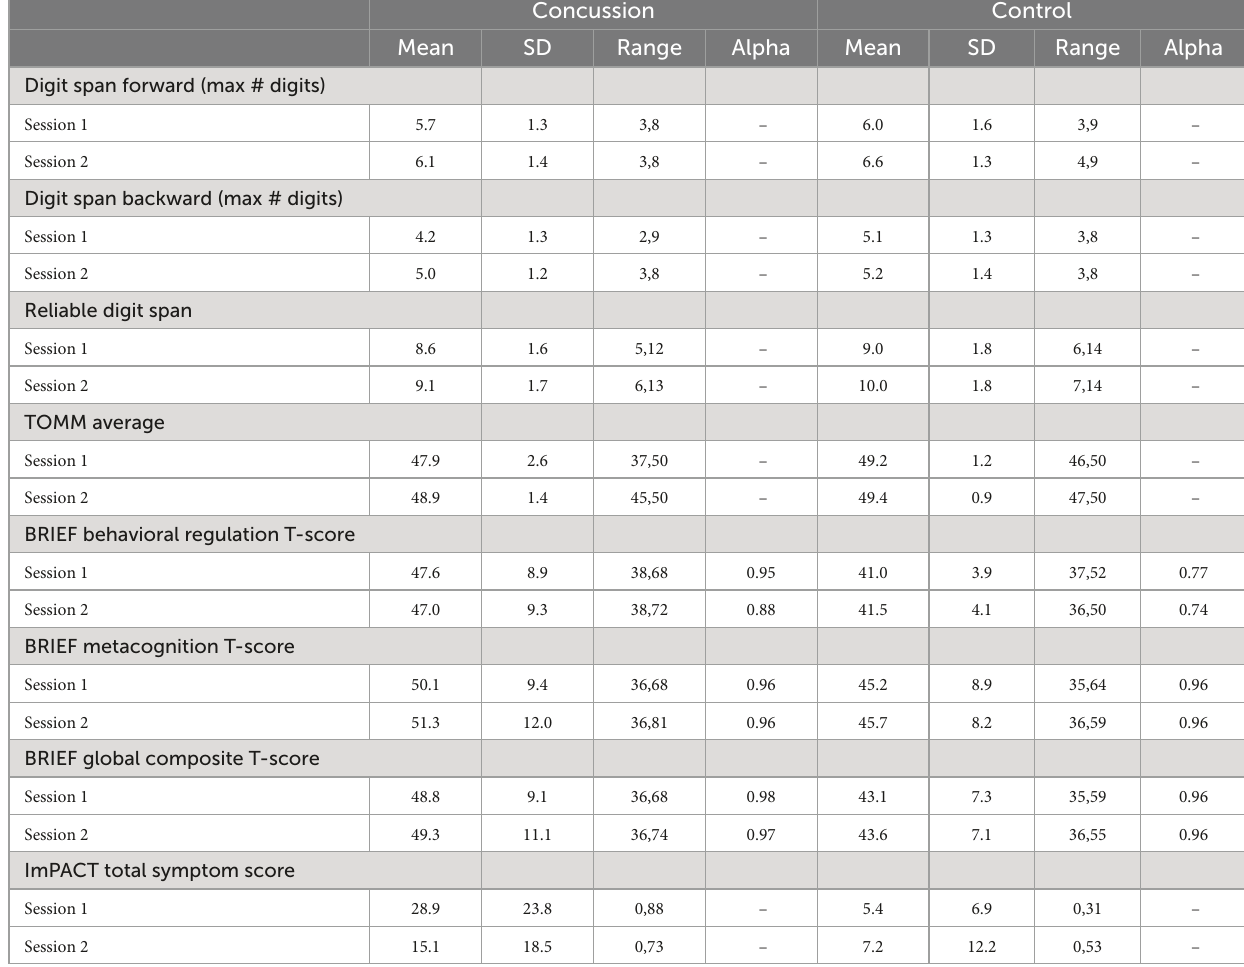
TABLE 2 Questionnaire scores and Cronbach’s